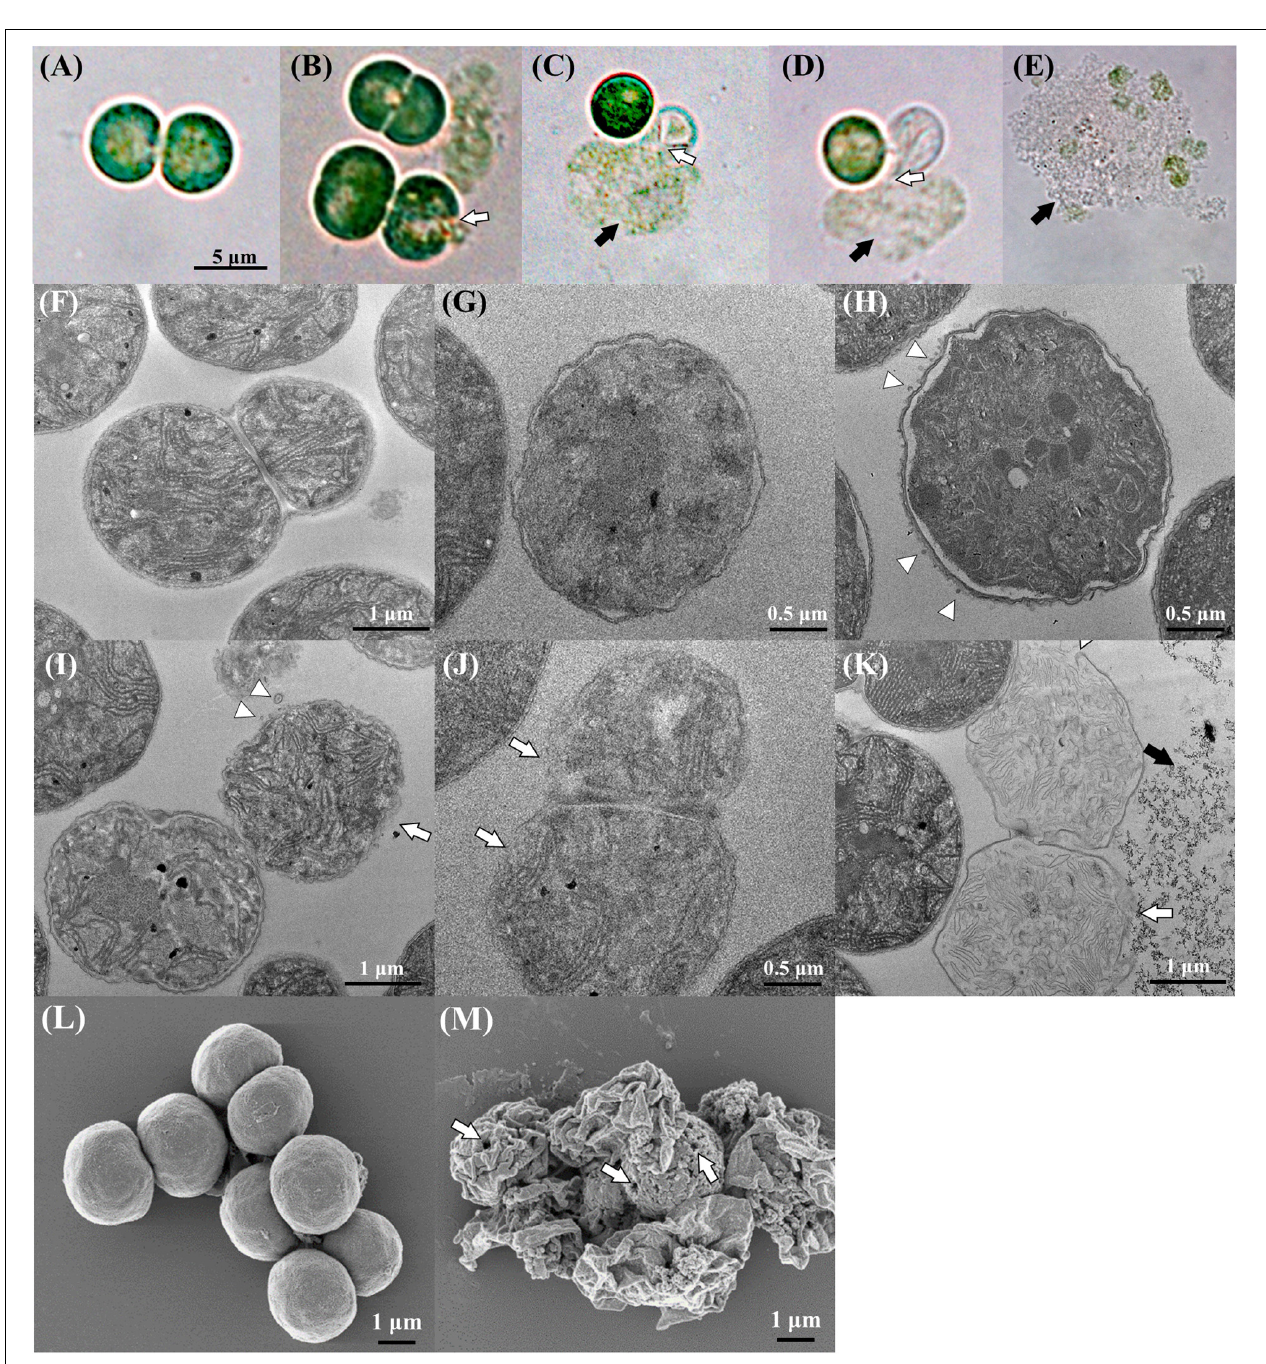
FIGURE 5 | DICM (A–E) , TEM (F–K) , and SEM (L,M) images showing the morphological changes in Microcystis aeruginosa NIES-298 cells upon mannitol treatment (50 µ M). Photographs (A,F,L) indicate intact cells without mannitol treatment and all mannitol-treated cells (B–E,G–K,M) were observed within 2 h (the SEM image in (M) was obtained at 2 h after mannitol treatment). After mannitol treatment, the proportion of damaged cells (F,K) increased over time. Open arrows, triangles, and closed arrows indicate the disruption of cell walls, outer membrane vesicles, and intracellular matter released from cells, respectively. Open arrows in (M) indicate pores formed on cell walls after mannitol